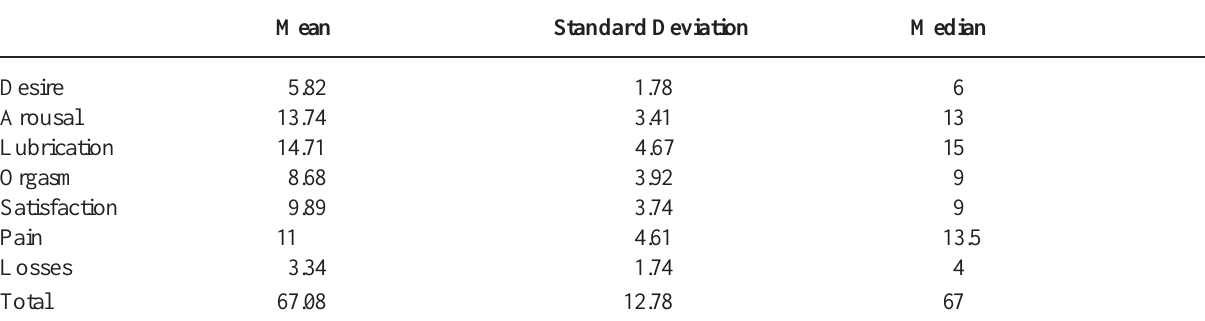
Table 3 – Scoring for the different questions among patients with sexual activity before the